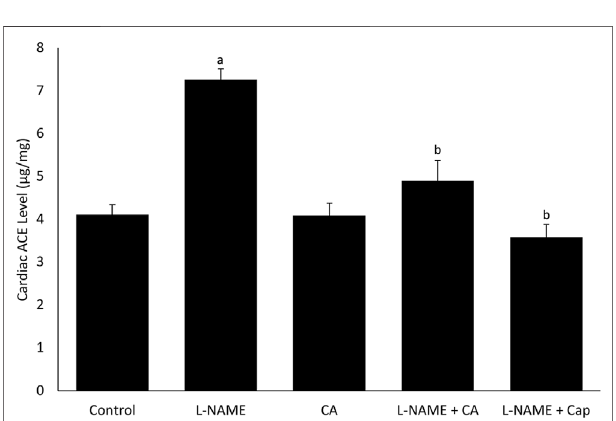
FIGURE4| Cardiacangiotensin-convertingenzyme(ACE)activityinrats treated with C. asiatica extract (500 mg/kg orally) or captopril (5 mg/kg orally) together with L -NAME (40 mg/kg orally) for 8 weeks. Bars represent mean ± SEM ( n (cid:1) 6). a versus control ( p < 0.05), b versus L -NAME ( p < 0.05).